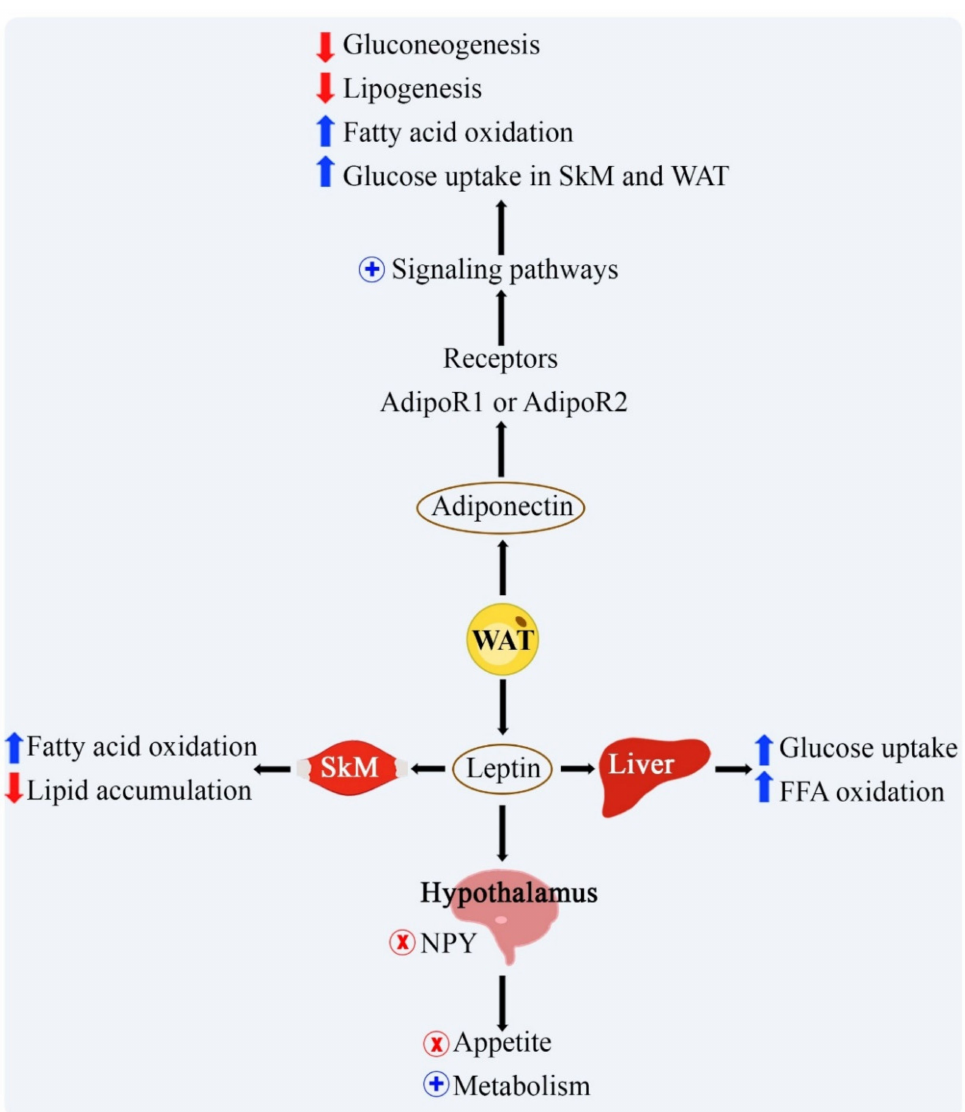
Figure 1. Effects of leptin and adiponectin on the metabolism of the central nervous system, skeletal muscle, and liver. Black arrows represent the flow in metabolism; blue arrow represents increased action; red arrow represents decreased action; + represents activation; x represents inhibition. FFA: free fatty acid; NPY: neuropeptide Y; SkM: skeletal muscle; WAT: white adipose tissue. In turn, omentin acts to improve insulin sensitivity and glucose absorption and acts as an anti-atherosclerotic factor. The main circulating form of omentin is